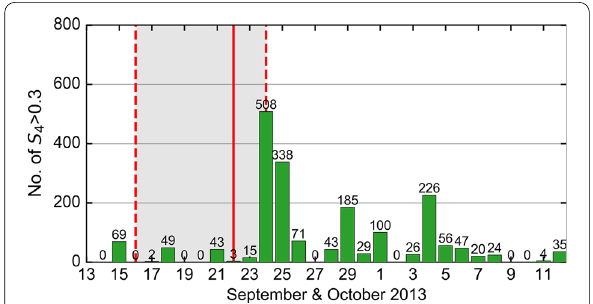
Fig. 6 Number of S 4 > 0.3 calculated from the ionospheric scintillation monitoring station during the period from 14 September to 12 October 2013. The life cycle of the Usagi was from 16 to 24 September 2013, as represented by the gray background area between two vertical red dashed lines. The vertical red solid line denotes the TC’s landfall near Hong Kong on 22 September